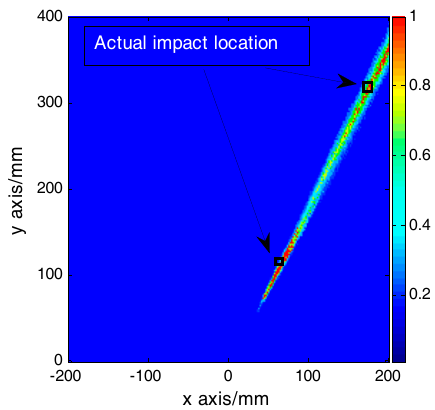
Figure 11. The localization spatial spectrum of (67,110) and (177,319).